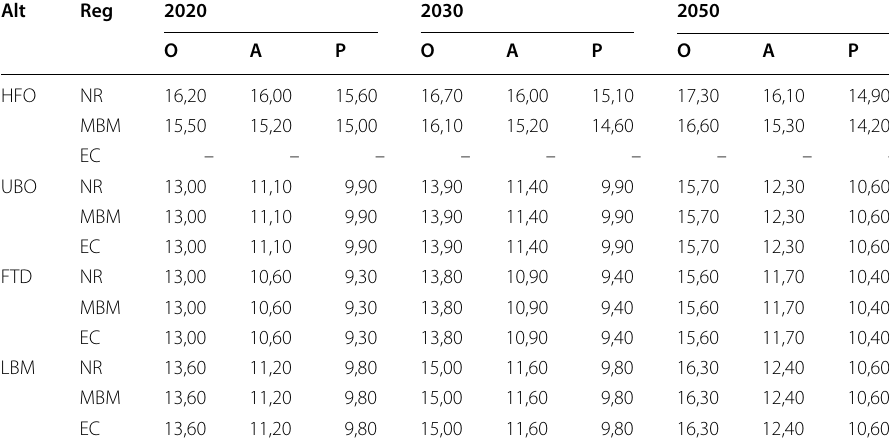
Table 10 Economic speed (kts) for all alternative fuels under optimistic (O), average (A), pessimistic scenarios (P), as well as no regulation (NR), market-based measures (MBM), and emission cap